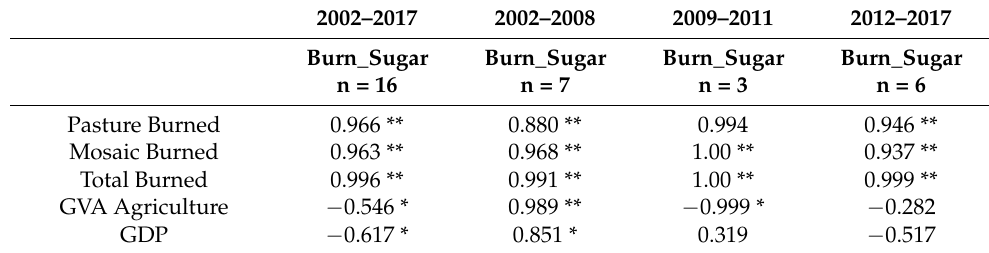
Table 5. Most commonly burned pixels by classification type between 2002 and 2017. Correlation analysis highlighting the relationship between the frequency of burned sugarcane and other agricul- tural land (i.e., pasture and mosaic of pasture and agriculture), as well as economic indicators for the study period,